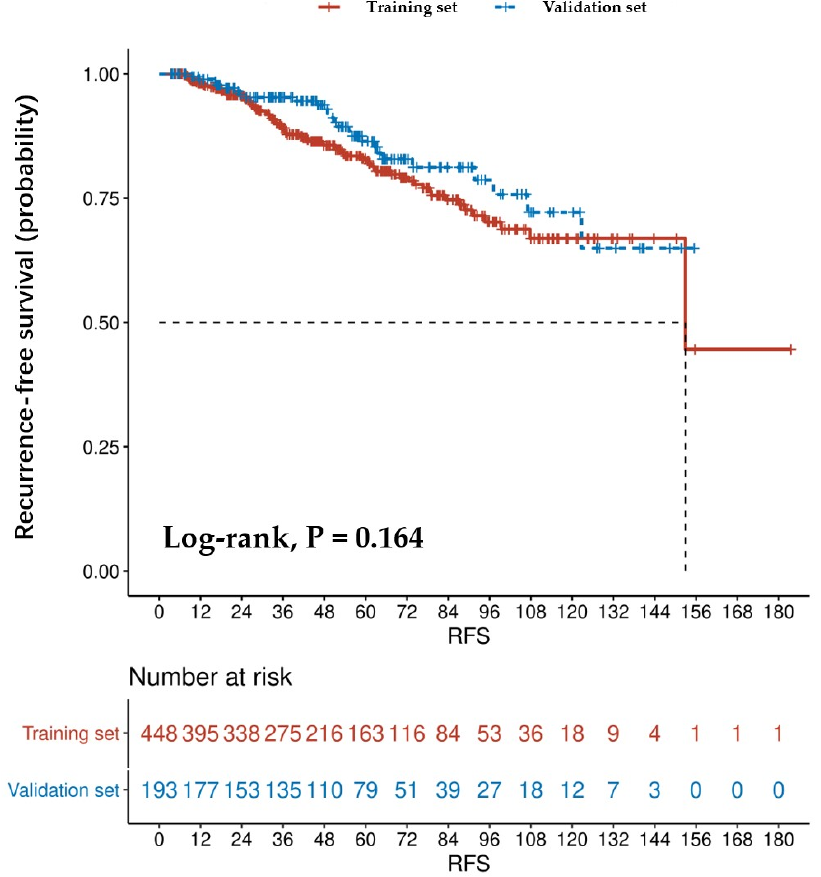
Figure 2. RFS curves of training ( n = 448) and validation ( n = 193) sets who underwent surgical resection.